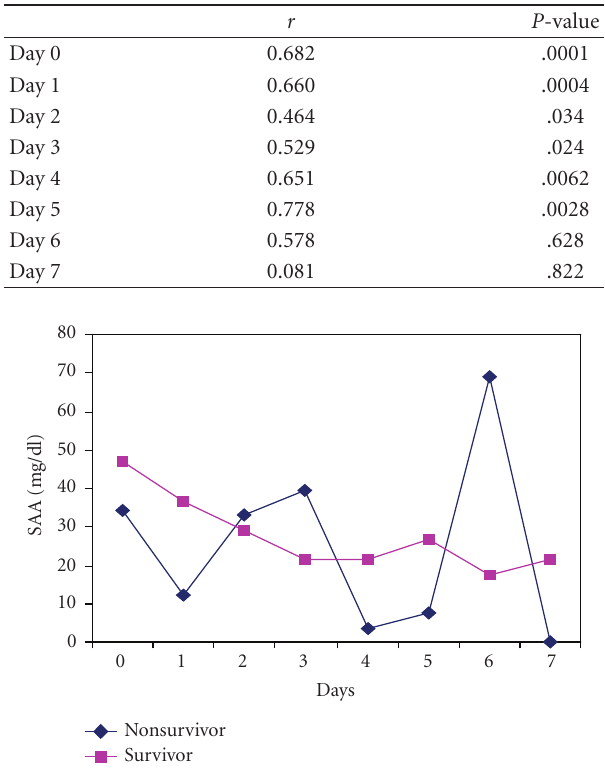
Figure 2: SAA evolution of survivors and nonsurvivors during the first week (NS). NS: not statistically significant. Table 5: Maximum likelihood, Wald statistic ( P